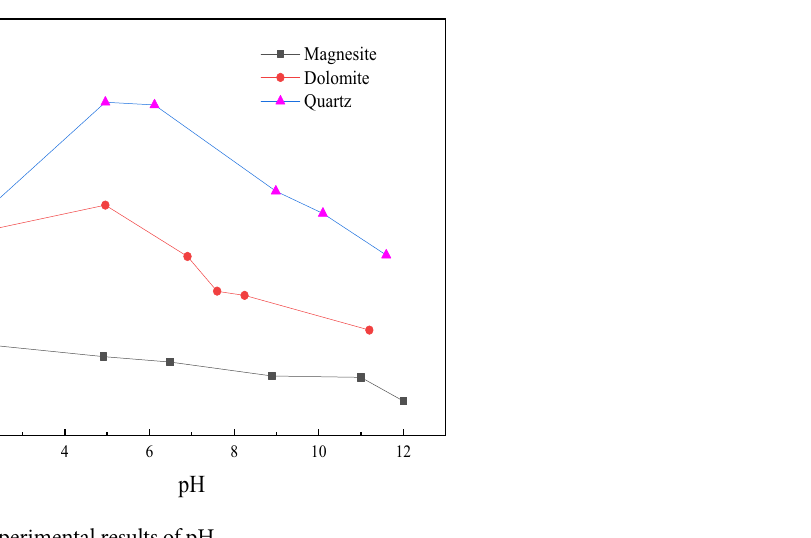
Figure 3. Experimental results of